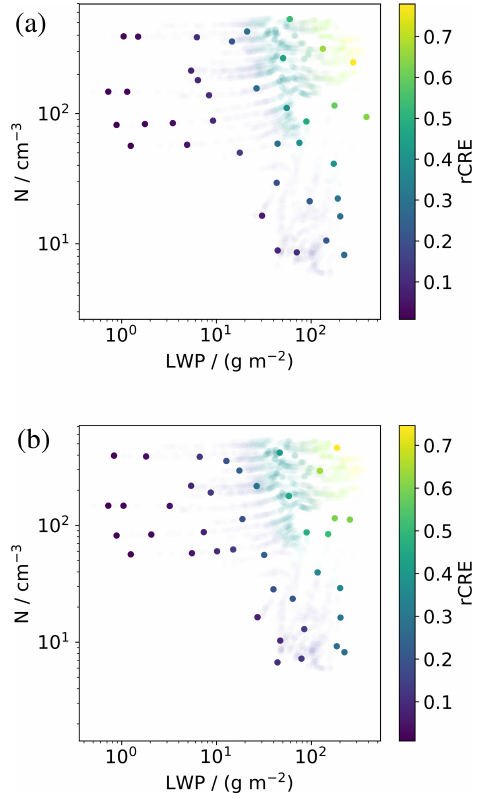
Figure 3. Subsampling (solid circles) from the total training data (opaque points) for the rCRE emulator ensemble members with the (a) lowest and (b) highest root-mean-square error (RMSE) in pre- dicting the validation data. The RMSE values are 0 . 010 and 0 . 024, respectively.